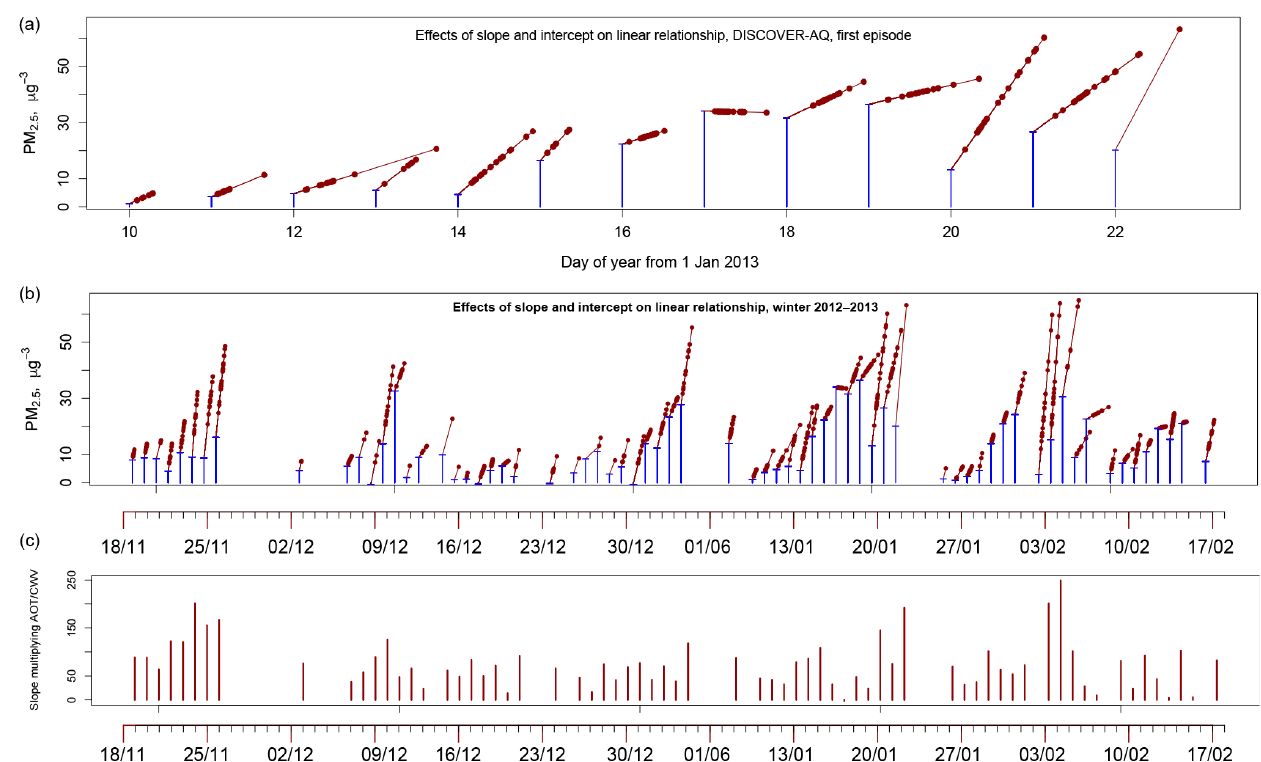
Figure 8. Roles of slopes and intercepts in a regression fit. (a) A “stork plot” for the clear-sky air-pollution episode mapped in Fig. 6. Vertical blue lines indicate the contribution of the random intercept α i to the total PM 2 . 5 fitted in the model. These are the same for all geographical locations including the observation stations for any given day. The slope parameter β i is the same for all geographical locations. (See note to Table 1.) Values of PM 2 . 5 evaluated at the stations are shown by red dots along a line. Large values of AOT / CWV have wide vertical extent, and the corresponding high values of PM 2 . 5 are shown as red dots at the upper right of each day’s plot. Highly sloped lines indicate high β i . (b) A stork plot for the whole wintertime interval evaluation, showing several clear-day episodes. (c) The values of β i vary considerably. These slopes are shown as a time